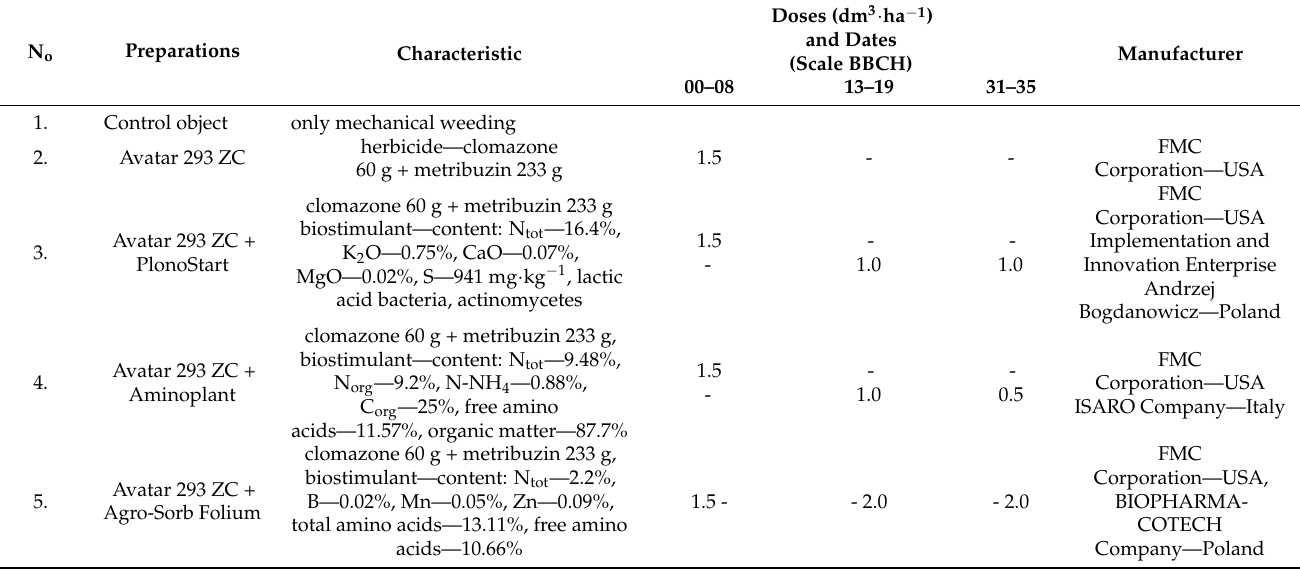
Table 1. Description of potato cultivars.